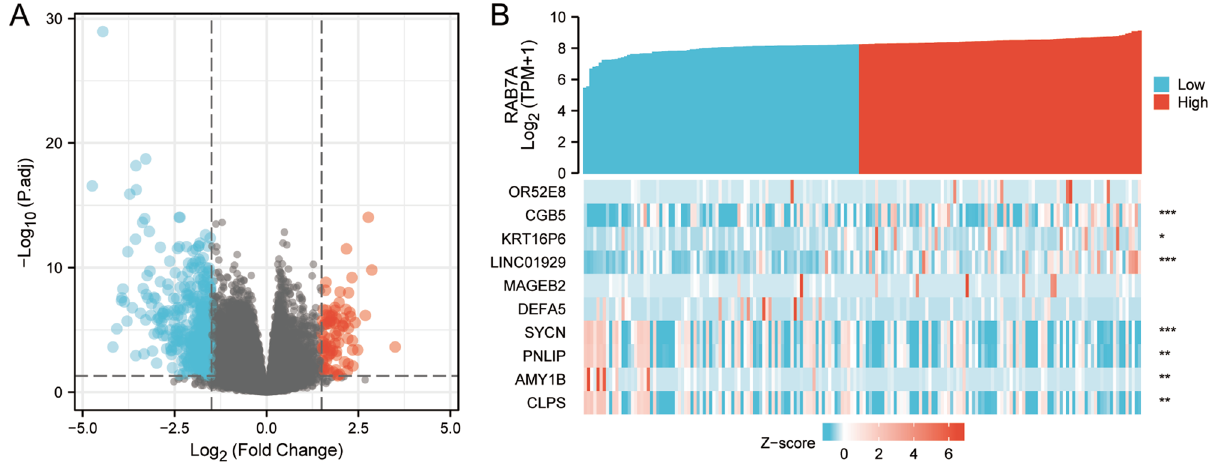
Figure 2. Between the groups with high RAB7A expression and those with low RAB7A expression, a total of 530 DEGs were confirmed to be statistically significant. ( A ) There are 84 up-regulated genes and 446 down- regulated genes in the volcano mapping of differentially expressed genes. The normalized expression levels are sorted from green to red in descending order. ( B ) A heat map of 10 differentially expressed RNAs, 5 of which are up-regulated and 5 of which are down-regulated. Green represents down-regulated genes; red represents up-regulated genes. The y-axis indicates differentially expressed RNA; the x-axis indicates the sample.